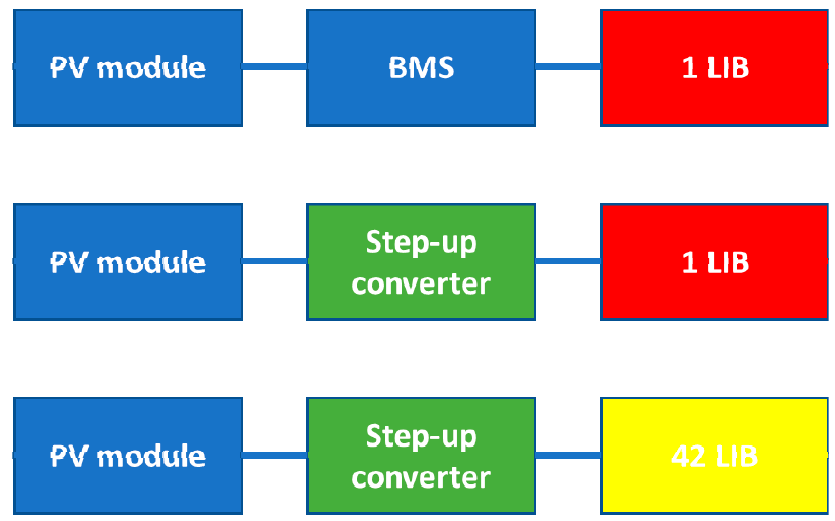
Figure 3. Scheme of various construction of energy storage systems.